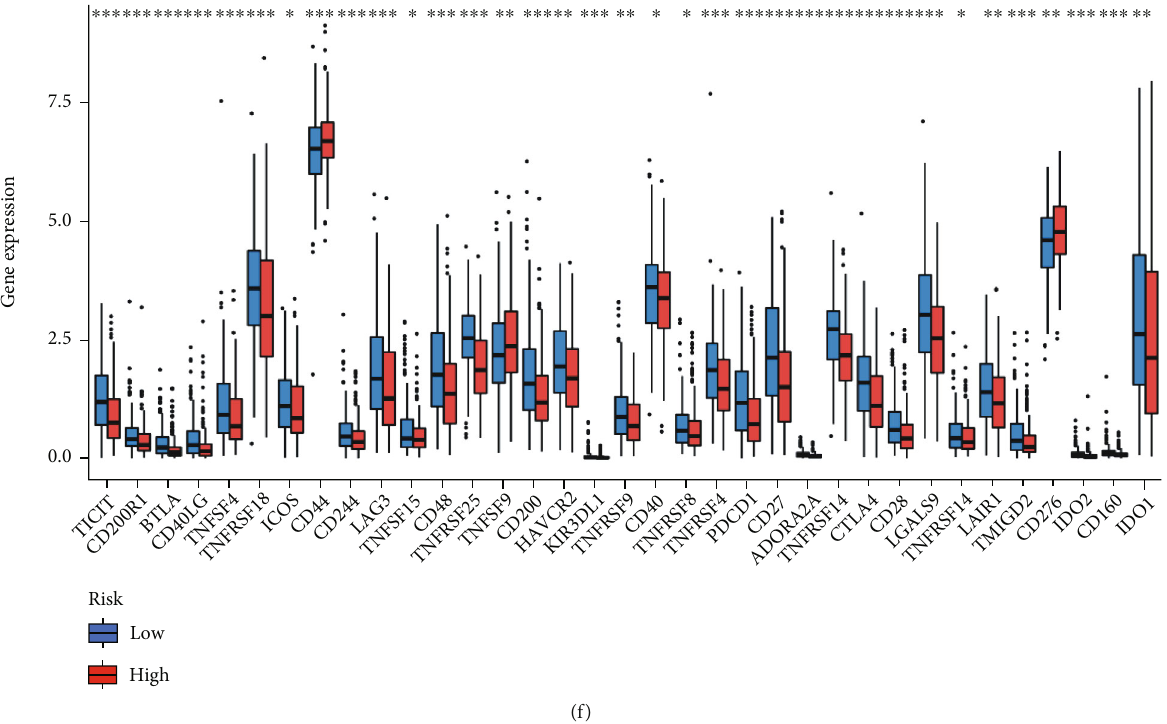
Figure 7: Correlation between RMA-AS_Score prognostic signature and immune checkpoint. (a) Correlation association analyses between risk score and immune checkpoint. (b – e) Correlation between risk score and immune checkpoint. (f) Comparison of immune checkpoint- related gene expression levels among di ff erent risk